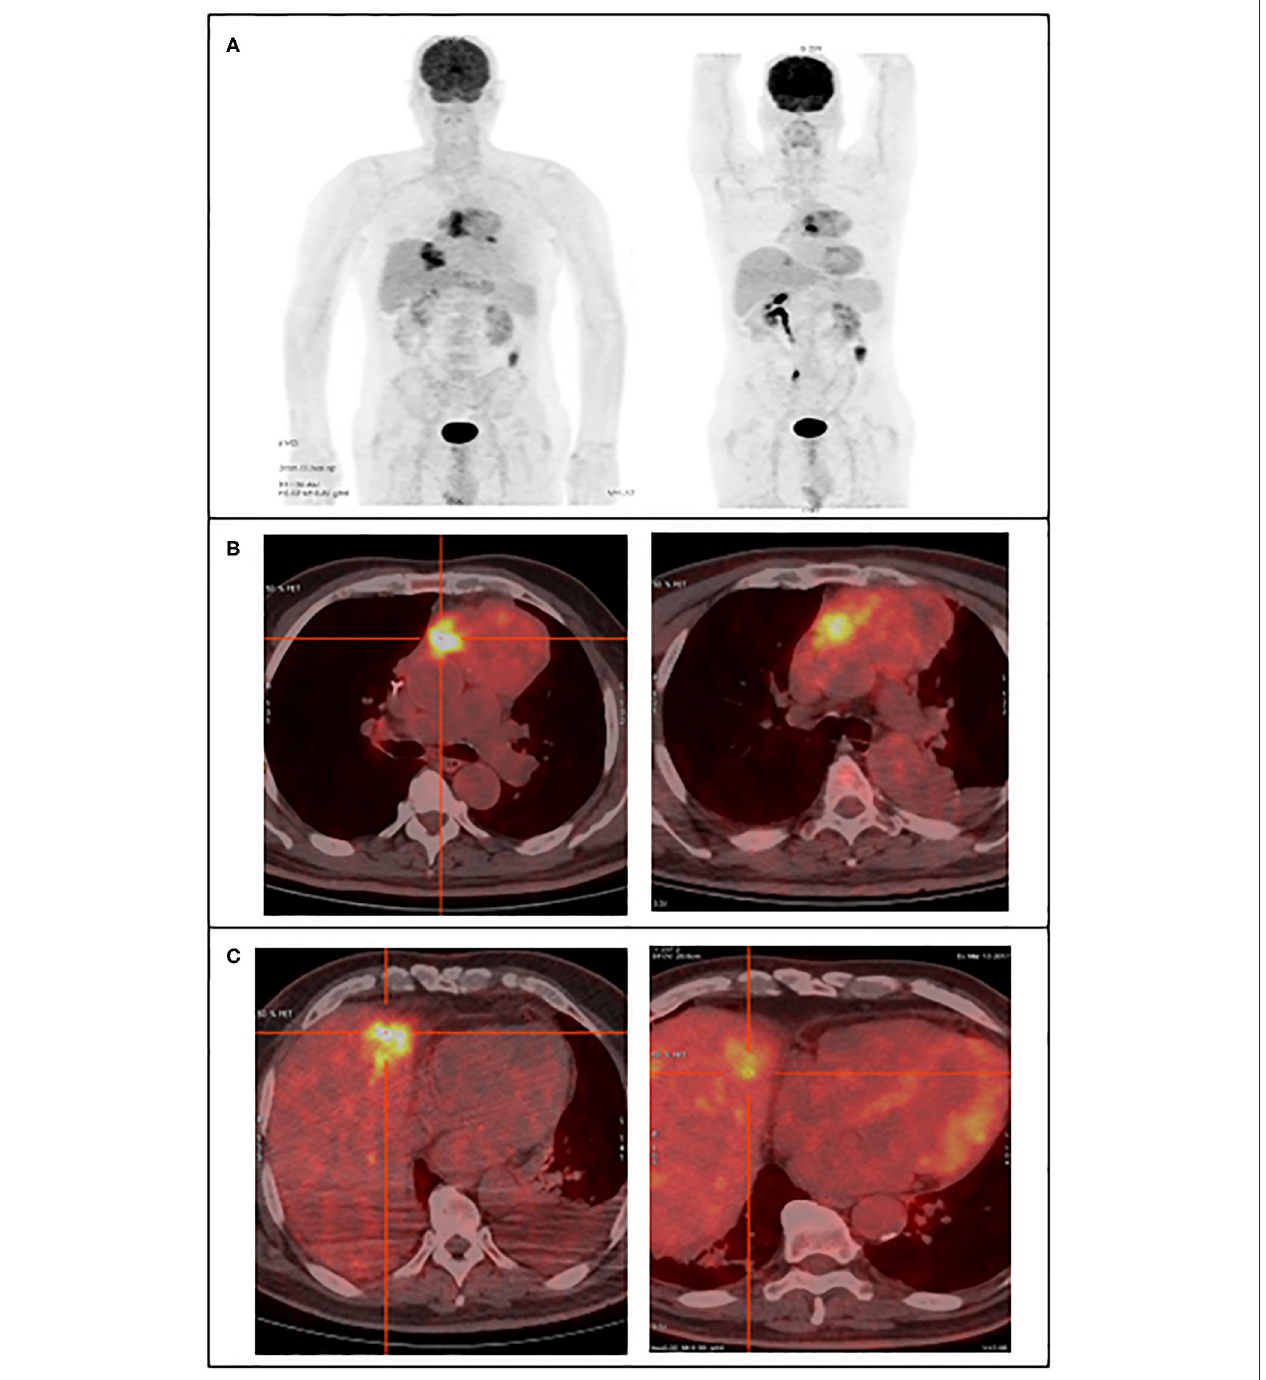
FIGURE 1 | 18F-FDG PET/CT images reveal the large hypermetabolic masses, in the superior mediastinum and the hepatic parenchyma, left figures before treatment and right figures post-treatment. (A) Maximum intensity projection image, (B) transaxial fusion image showing the mediastinal tumor, (C) transaxial fusion image showing the liver tumor. have genetic changes in the coding sequence of the following We found 30 variants shared between primary tumor and genes: ALK (3 variants), CDKN2A (2), and PIK3CA (1) metastasis, distributed across 12 genes, and having a similar ( Figures 2 , 3 frequency between the two samples. Among these variants, 6